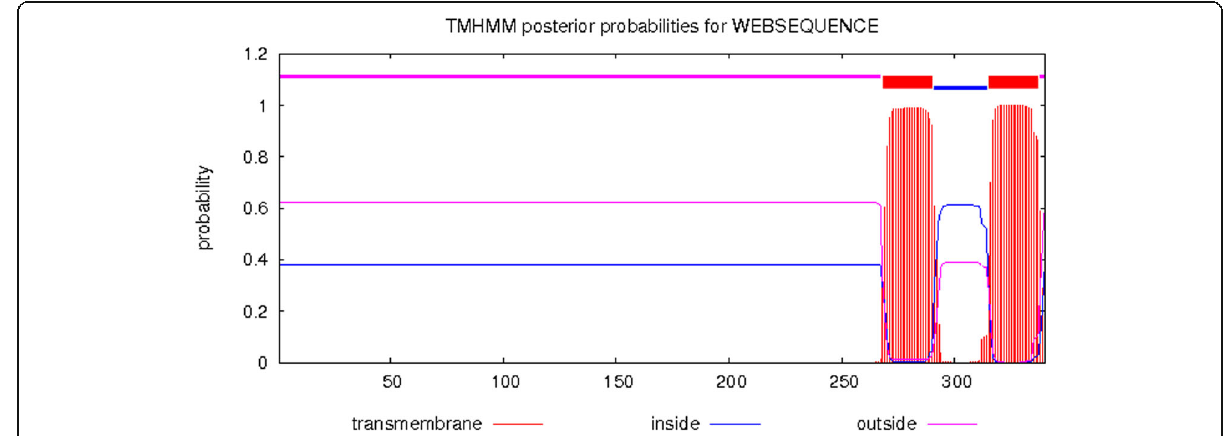
Fig. 5 Transmembrane domain analysis of PRRT2